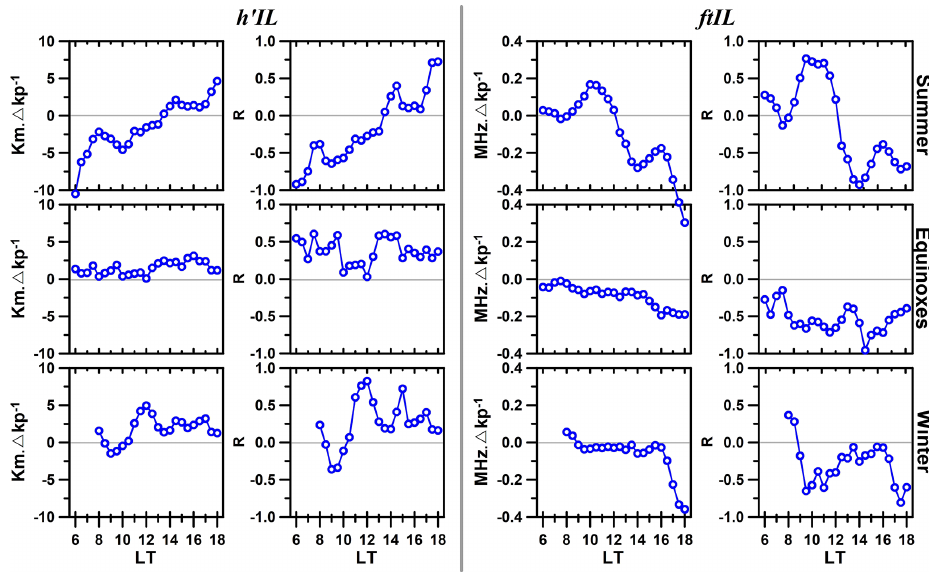
Figure 6. Geomagnetic activity effects on h’IL and ftIL parameters for different seasons. The first two panels (from left to right) show the linear regression of the h’IL as a function of the (cid:49) Kp av index over the different times of the day and the correlation coefficient R . The two right panels indicate the same but for the ftIL